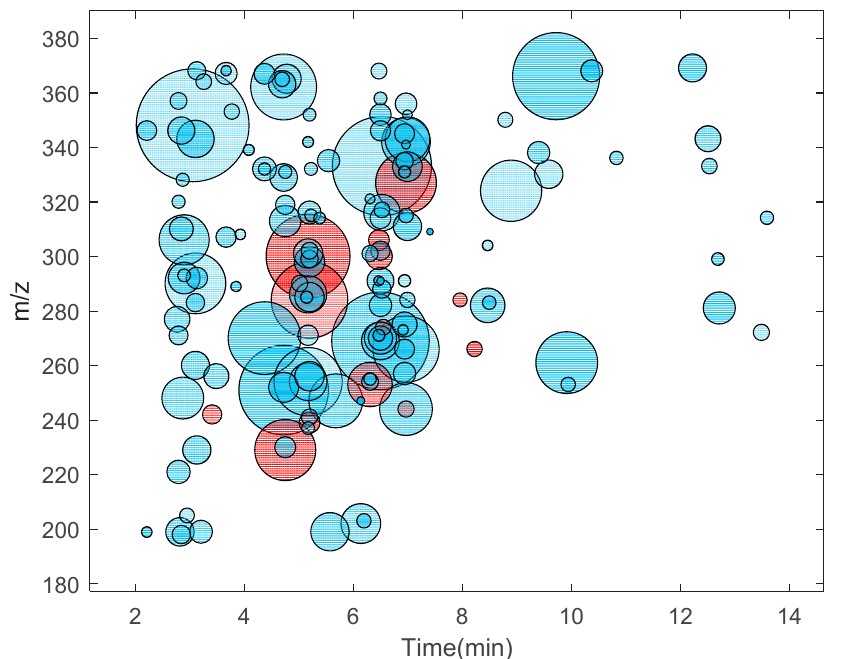
Figure 2. An adductome map ( m / z of detected adduct ions vs. elution time) of the putative DNA adducts found in M. affinis (pool of 12 individuals) using nLossFinder shown as blue circles. The areas of the circles are proportional to the area of the adduct ion peaks (ranging from 1.8 × 10 4 to 1.2 × 10 8 peak area units). The circles in red correspond to the adducts that were found manually in a previous study (Gorokhova et al. [6]). For a list of putative adducts in M. affinis detected in this study and earlier [6], refer to the Supplementary Information (Table S1).